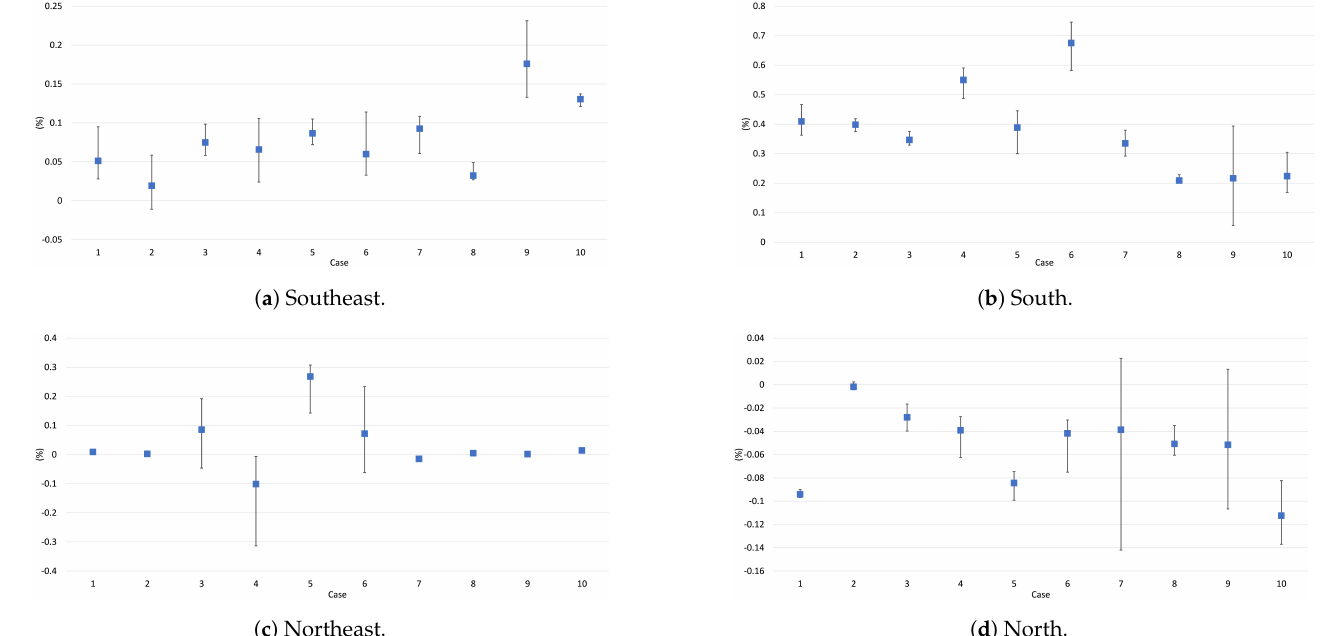
Figure 16. Differences in the stored energy in % of the maximum stored energy in each subsystem. The difference is computed as SE a , subs SE z , subs , where SE is the energy stored in %, a is the aggregated model, z is the zone model, and − subs is a particular subsystem. The squared marks give the average of the difference stored energy over the five trials of each case, while the error bars indicate the minimum and maximum over the five trials. Positive differences indicate that more energy is stored in the aggregated model. In ( a ), we show the differences for the Southeast system; ( b – d ) present the data, respectively for the South system, Northeast, and